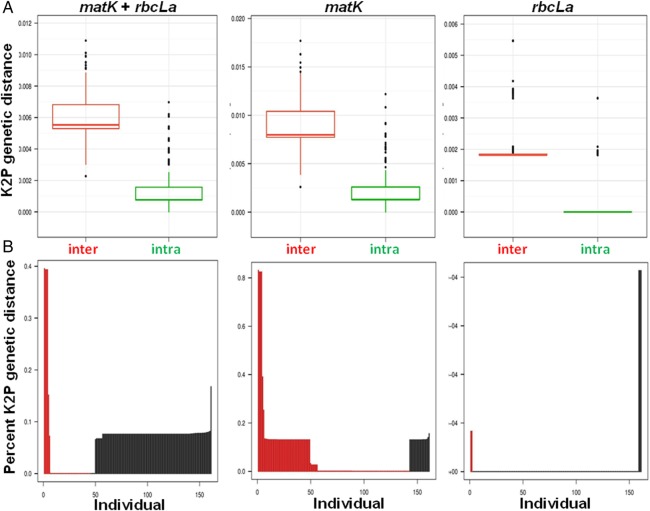
(A) Evaluation of barcode gap in the data set. Boxplot of the interspecific (inter) and intraspecific (intra) genetic distances for matK + rbcLa, matK and rbcLa data sets, indicating the existence of a barcode gap, i.e. minimum interspecific distance is greater than the maximum intraspecific distance. The bottom and top of the boxes show the first and third quartiles, respectively, the median is indicated by the horizontal line, the range of the data by the vertical line and outliers by dots. (B) Line plot of the barcode gap for the 171 Psoraleiod individuals. The black lines indicate where the minimum interspecific distance is greater than the maximum intraspecific distance (an indication of a barcode gap); the red lines show where this pattern is reversed, i.e. the situation where there is no barcoding gap.